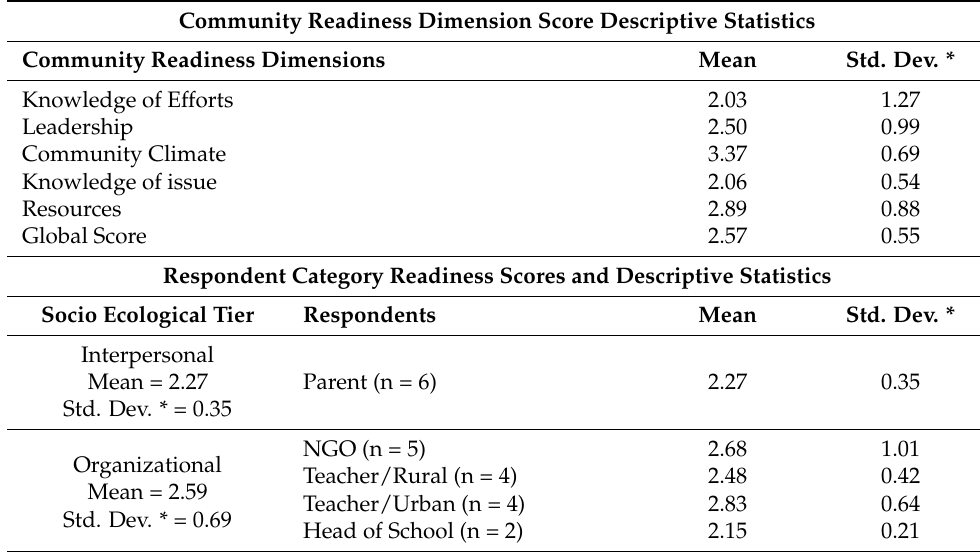
Table 1. Community readiness dimension score, respondent category readiness scores, and tier wise readiness scores based on rater consensus